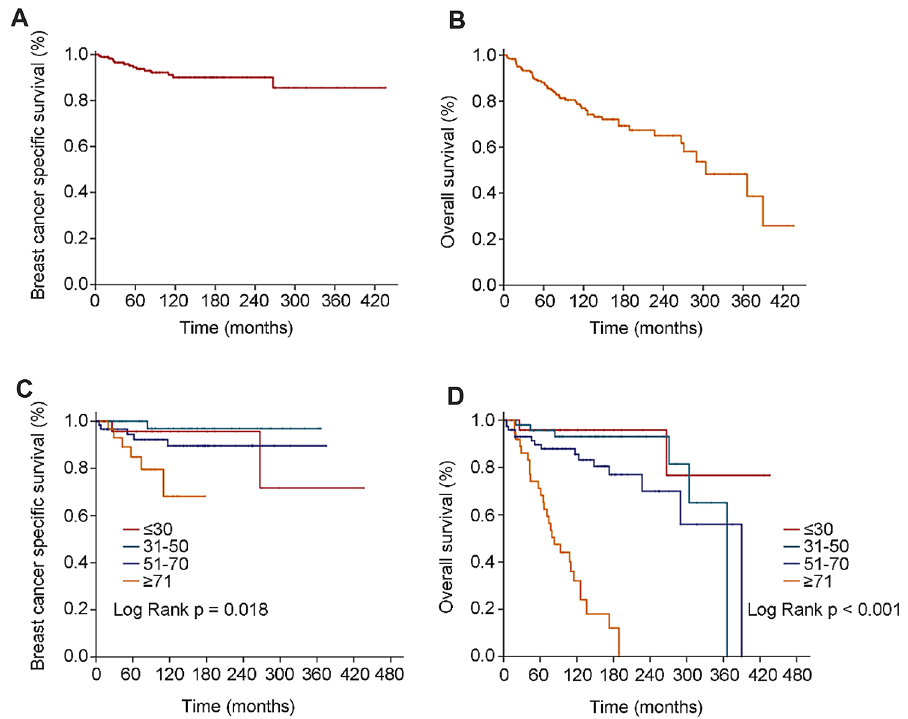
Figure 2. OS (overall survival) and BCSS (breast cancer specific survival) of study cohort. ( A ) Kaplan and Meier estimates BCSS. ( B ) Kaplan and Meier estimates of OS. ( C ) Kaplan and Meier estimates of age-related BCSS. ( D ) Kaplan and Meier estimates of age-related